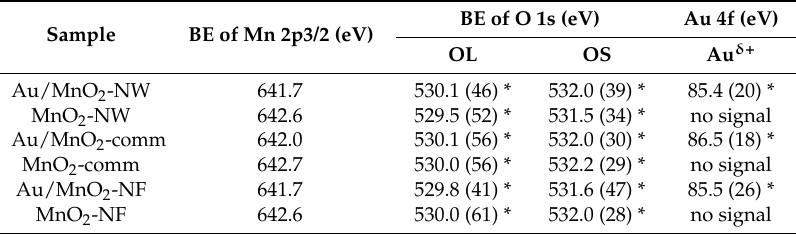
Table 4. Binding energies measured by XPS before and after the deposition of Au NPs at the surface of the different MnO 2 supports (OL—lattice oxygen species, OS—oxygen ions).